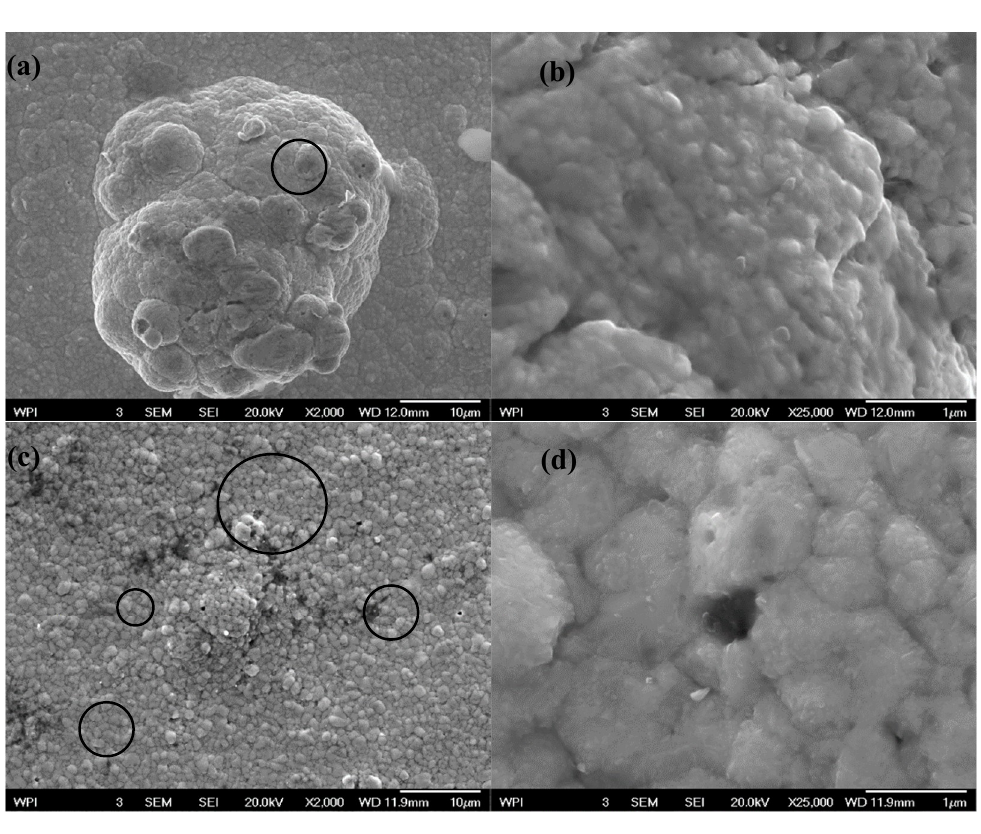
Figure 12. SEM image of the Pd-Au membrane befor ( a , b ) and after the permeation tests ( c , d ).